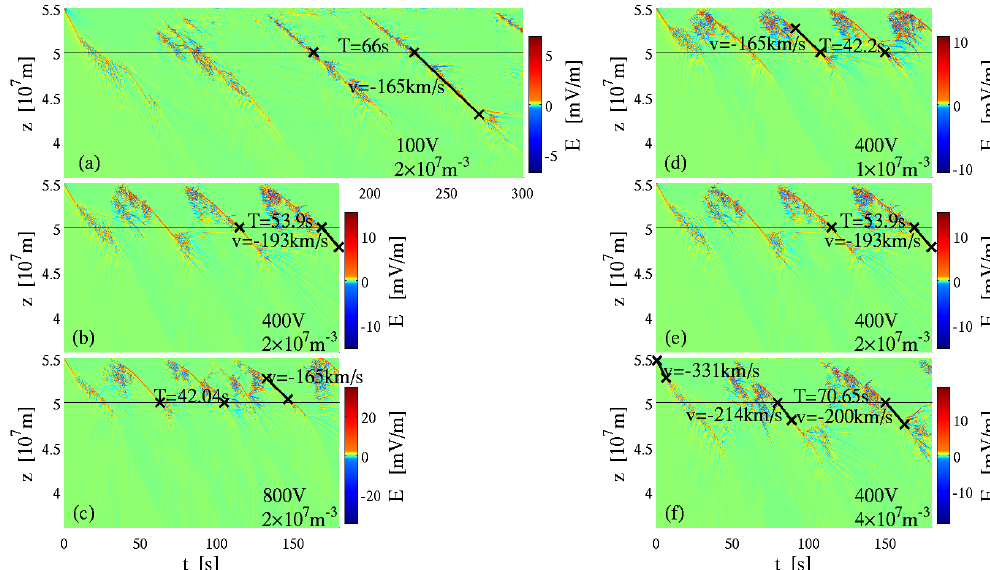
Figure 5. Comparing t − z diagrams of E in different simulation runs. (a–c) Constant ionospheric density, 2 × 10 7 m − 3 , and three different voltages, namely 100, 400, and 800V. (d–f) Constant voltage, 400V, and three different densities at the ionospheric boundary, 1, 2, and 4 × 10 7 m − 3 . Panels (b) and (e) show the same run. The standard run presented in the other figures corresponds to panel (f) . Examples of the period between double layers passing z = 5 × 10 7 m (altitude 5 . 1 × 10 3 km) and of double layer velocities are shown in each